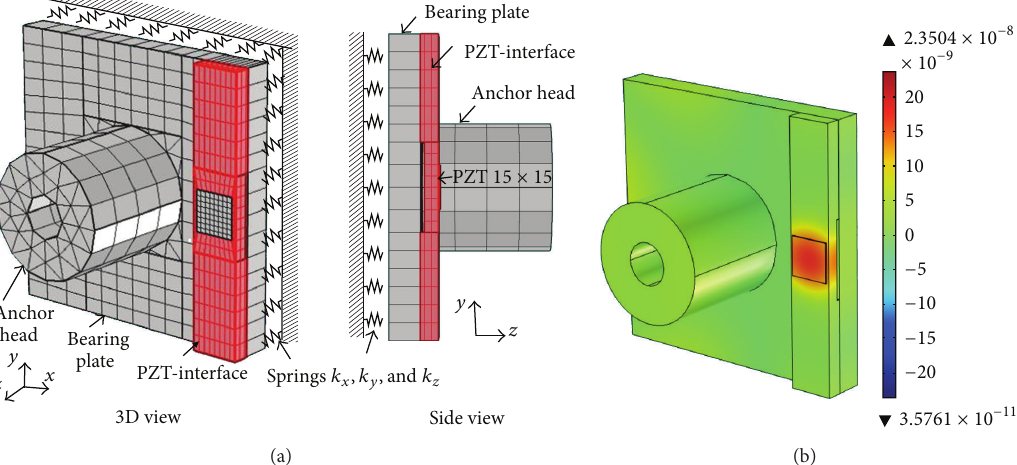
Figure 6: FE model of tendon-anchorage subsystem: (a) meshing and boundary condition and (b) deformation excited by PZT sensor at 19.52 kHz.